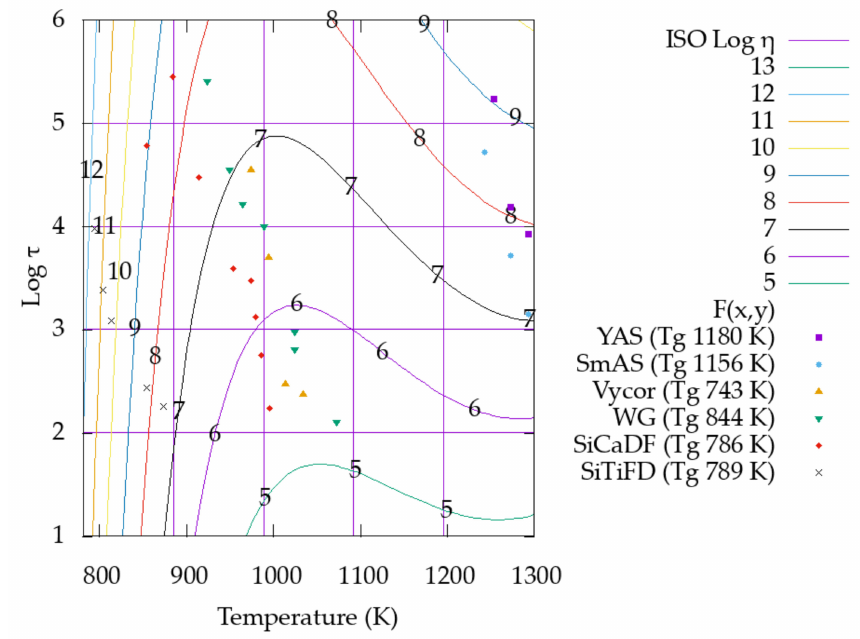
Figure 9. T , log( τ ) experimental data points and iso-viscosity lines from the master function η = η ( T , τ ) built in this section. It is possible to observe that T , τ data for the same glass is along a line and T g increases from left to right. τ in s, viscosity in Pa s.